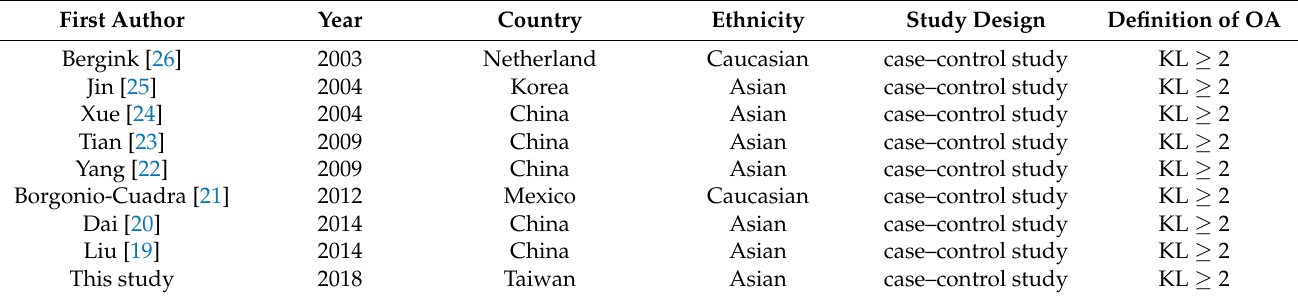
Table 3. Studies’ characteristics in the